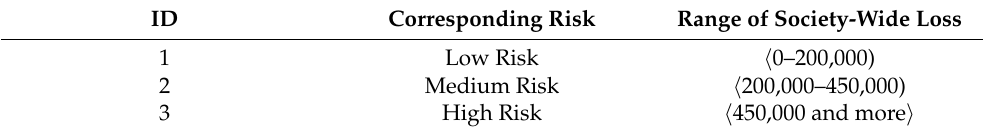
Table 3. Distribution of traffic accidents into selected groups depending on the society-wide